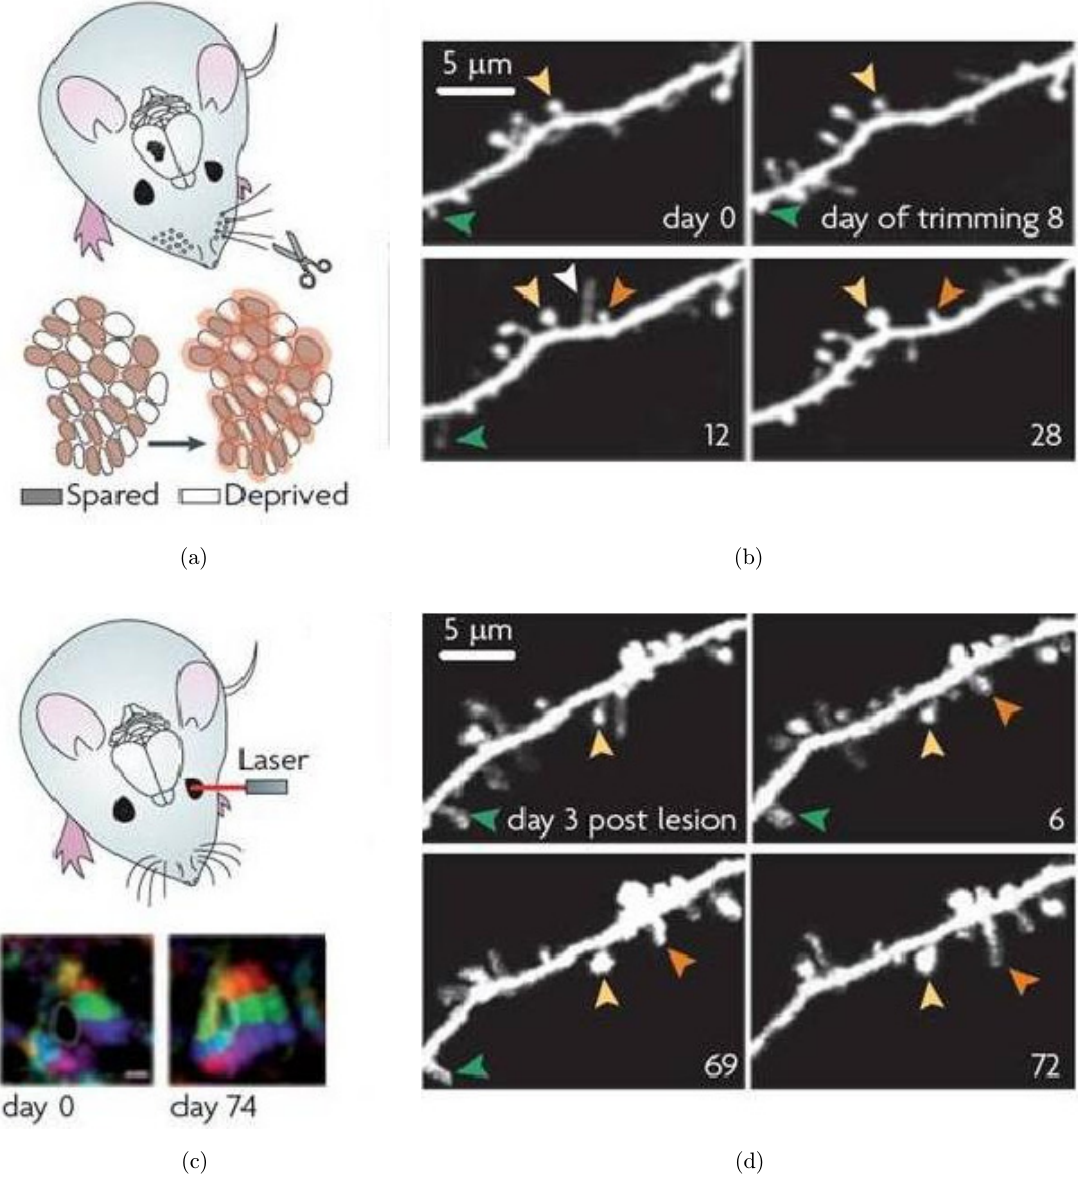
Fig. 5. Experience-dependent spine plasticity in the adult neocortex. (a) Chessboard whisker trimming causes changes in the whisker representational map in the barrel cortex. (b) Time-lapse TPF images of dendritic spines in the barrel cortex before and after chessboard whisker trimming. Many spines are stable (yellow arrowhead), but some appear and disappear (white arrowhead). New persistent spines (orange arrowhead) are more likely to grow after whisker trimming, whilst previously persistent spines (green arrowhead) are more likely to disappear. (c) Immediately after a focal lesion in the retina the lesion projection zone in the neocortex is unresponsive to visual stimulation, as measured by intrinsic signal optical imaging (bottom, day 0). The size of the unresponsive region decreases with time. Scale bar, 700 (cid:1) m. (d) Time-lapse of dendritic spines in the visual cortex after unilateral focal lesion in the retina. Although some spines are present over more than two months of imaging (yellow arrowhead), most spines are lost (green arrowhead) and replaced by new persistent spines (orange arrowhead). Adapted with permission from Ref.